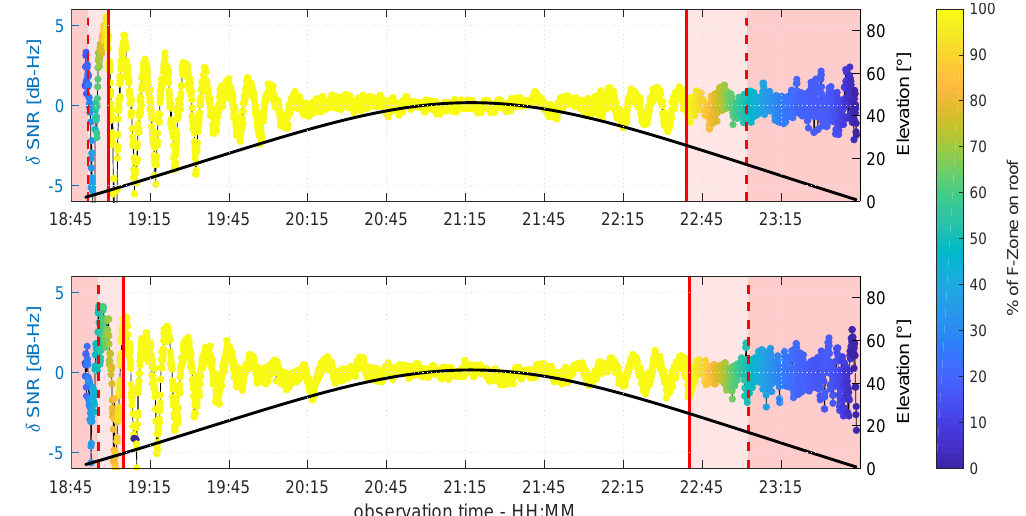
Figure 19. Color coded δ -SNR time series of G19 observed at antenna A ( top panel) and antenna B ( bottom panel). The black line shows the elevation angle of G19 during the observation period.